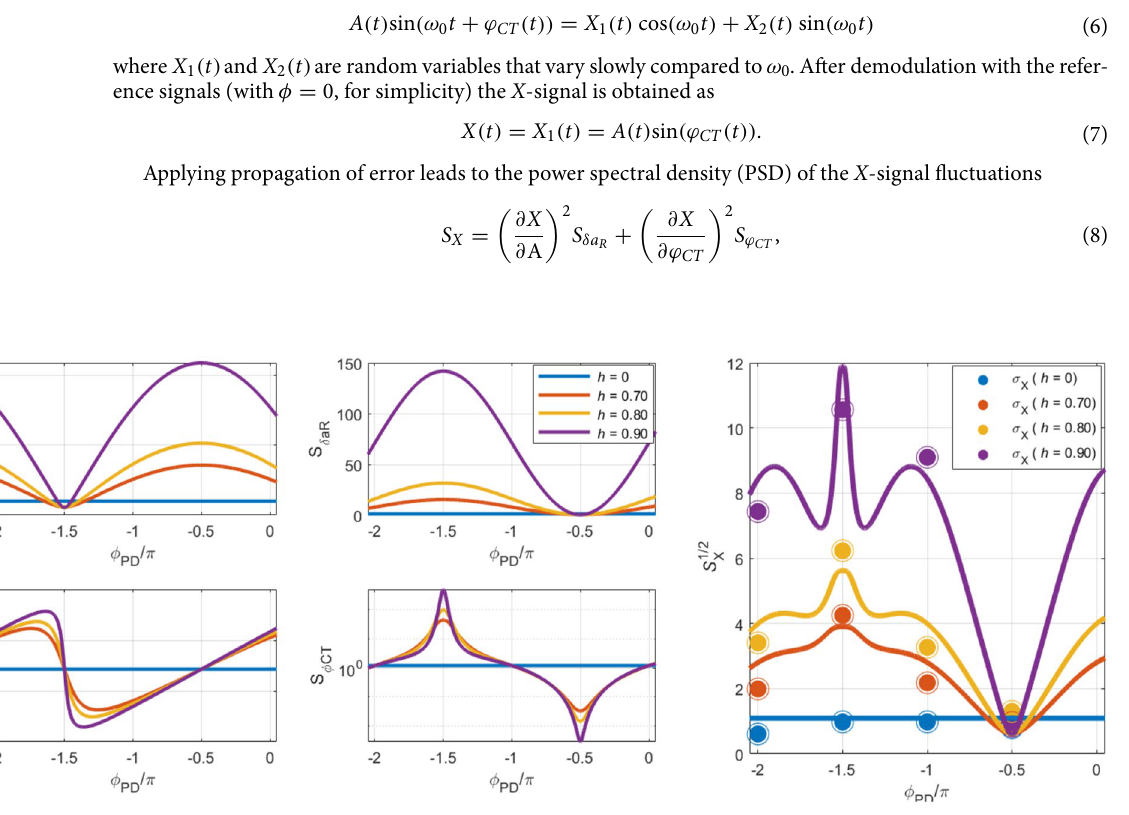
where X 1 ( t ) and X 2 ( t ) are random variables that vary slowly compared to ω 0 . After demodulation with the refer-